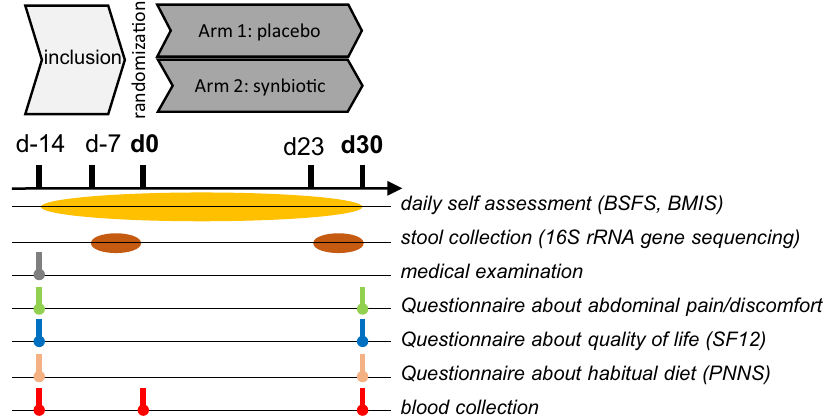
Figure 5. Overview of the clinical study. BMIS Brief Mood Introspection Scale, BSFS Bristol Stool Form Scale; SF12 12-item short form survey measuring the eight health domains for adults (providing psychometrically- based physical component summary and mental component summary scores), PNNS French National Nutrition and Health